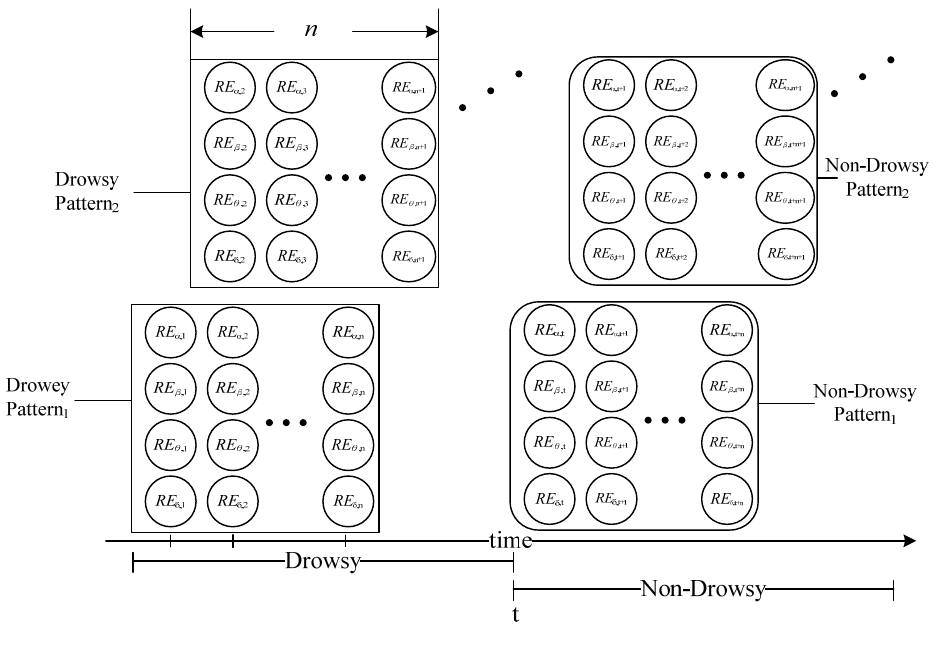
Figure 2. An example of EEG feature